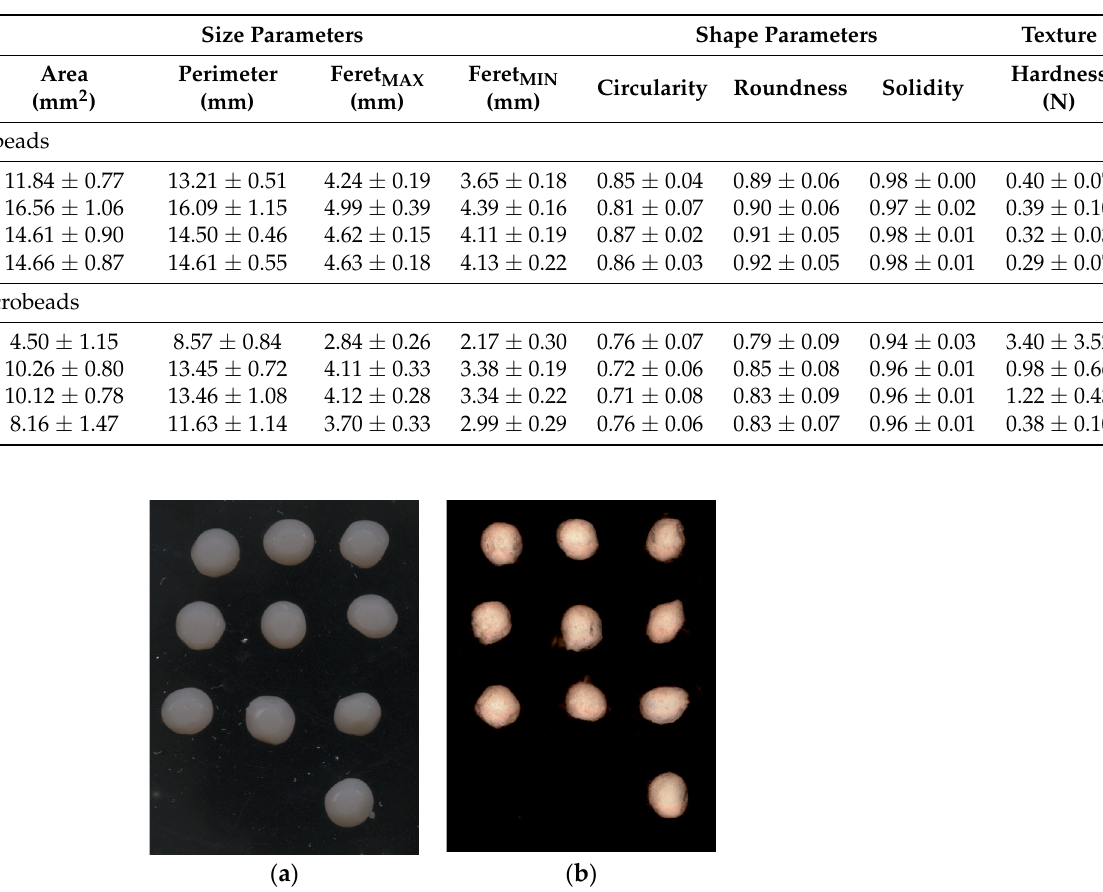
Table 6. Values of parameters describing the size (area, perimeter, Feret), shape (circularity, roundness, solidity), and texture (hardness) of the hydrogel and freeze-dried microbeads containing phenol-rich grape pomace extract, prepared using sodium alginate (SA), SA and gelatin (SA + GEL), SA and gum arabic (SA + GA), and SA and chitosan (SA/CHIT) as coatings.